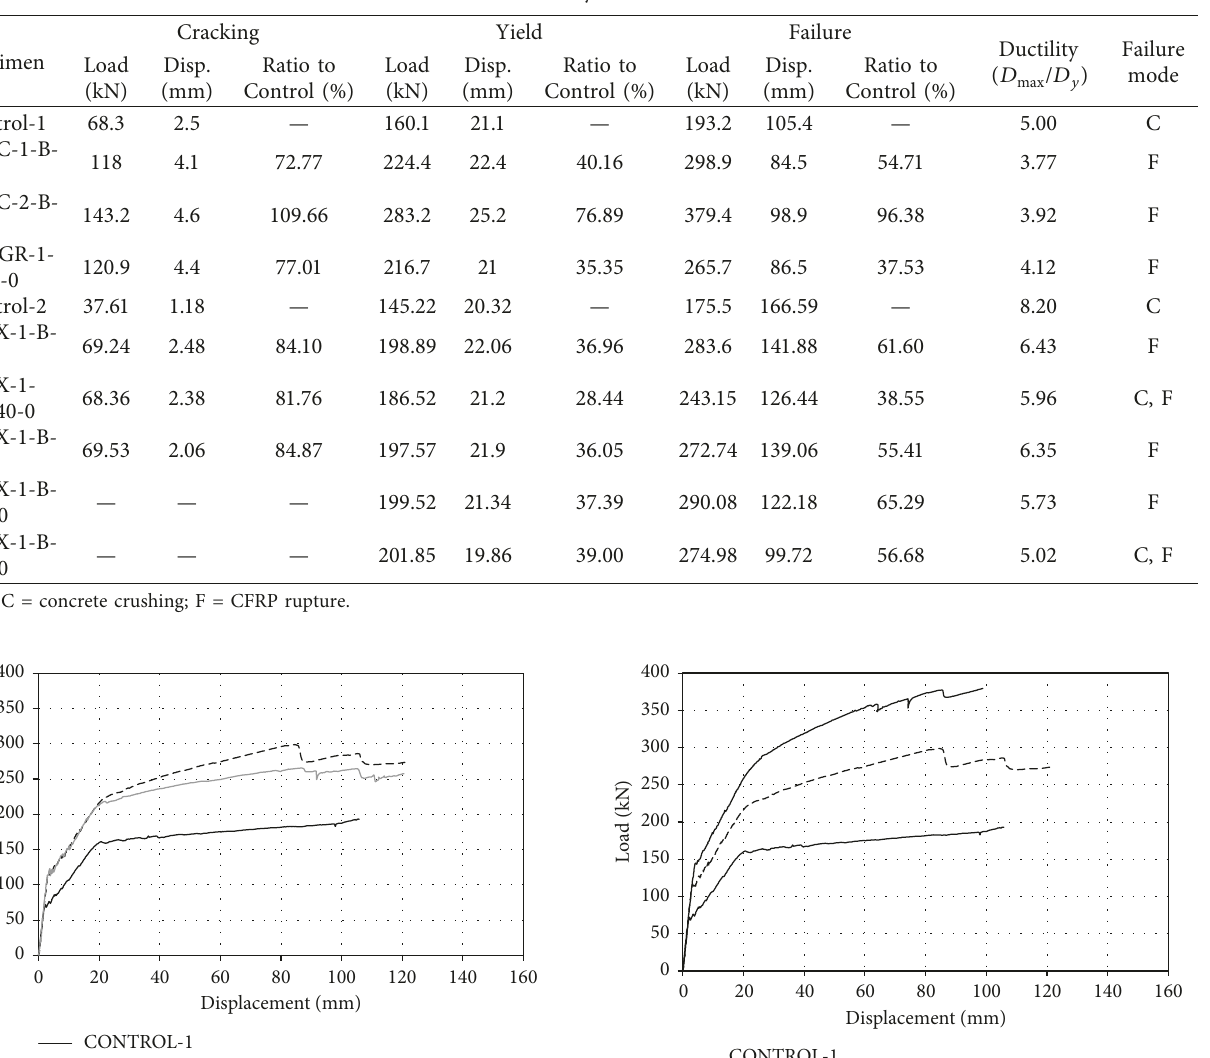
Table 7: Summary of test results.